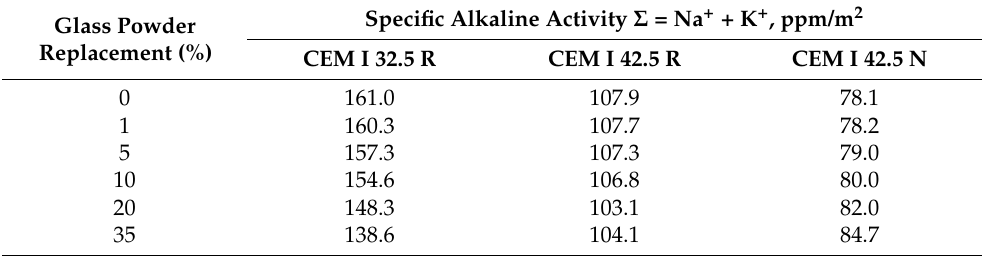
Figure 1. The alkaline activity K + ( a ) and Na + ( b ) of various cement types with varying mass replacement of waste glass powder. Table 3. Calculated alkaline activity of cement compositions with the addition of brown glass powder.